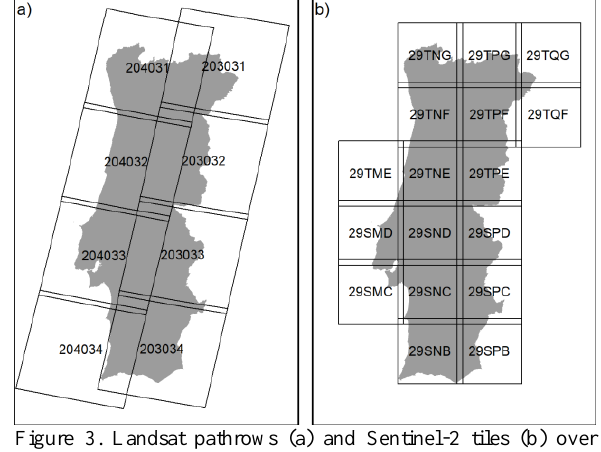
Figure 3. Landsat pathrows (a) and Sentinel-2 tiles (b) over mainland Portugal.